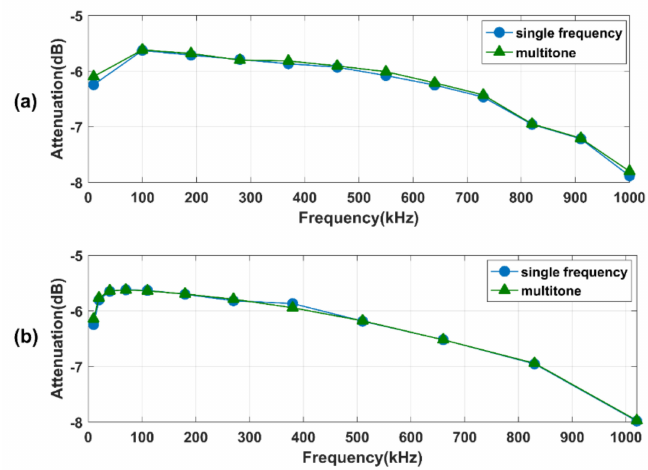
Figure 6. The calibration results of the measurement system for linear ( a ) and quasi-logarithmical ( b )